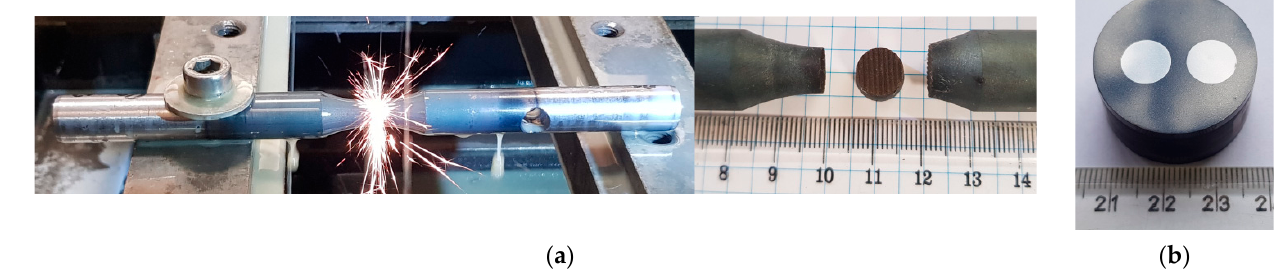
Figure 5. Method of sampling for metallographic tests from material after physical modelling: ( a ) general view and ( b ) sample metallographic microsections.